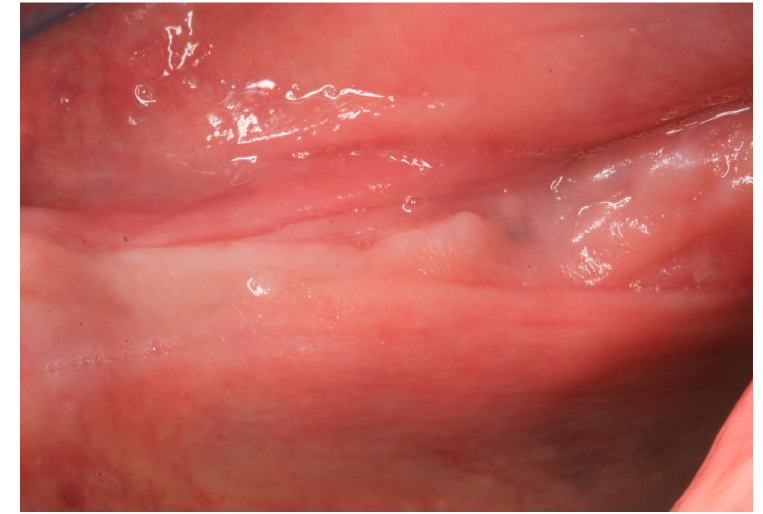
Figure 4. Case 1: Resolution of the bone exposition.